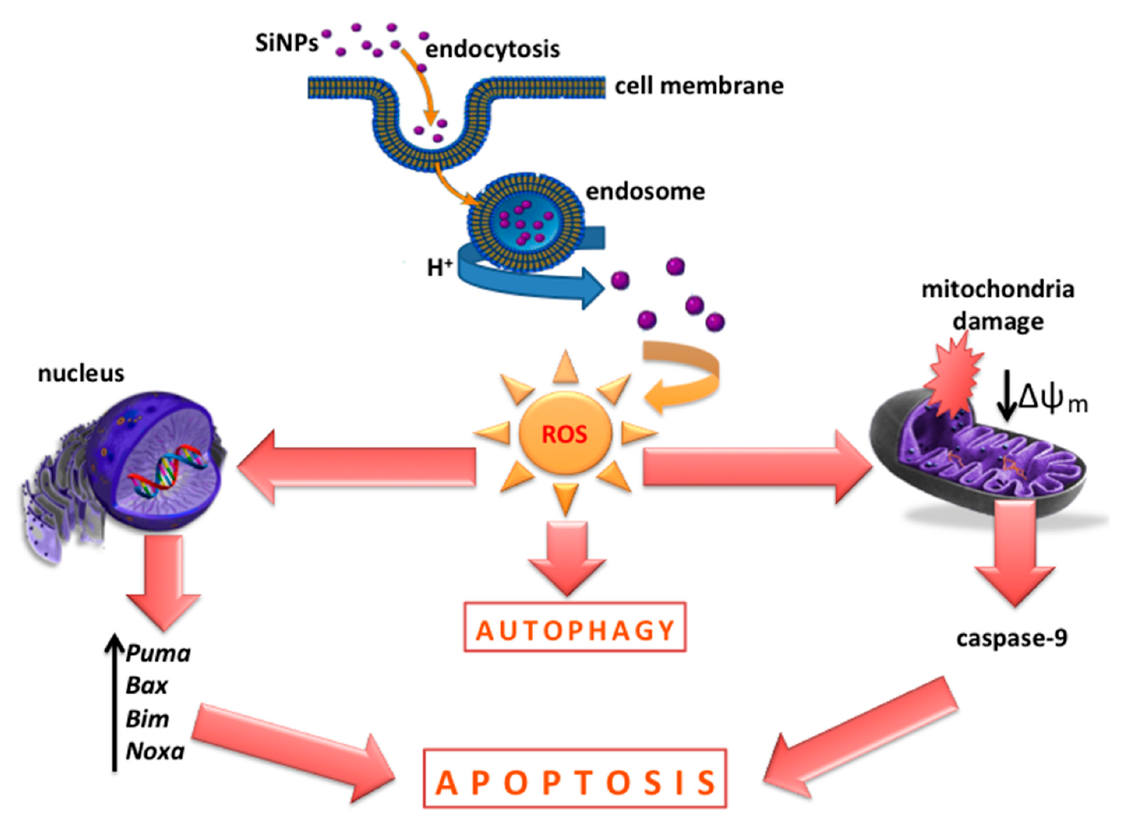
Figure 7. The effect of SiNPs on apoptosis, autophagy, and their suggested mechanism in glioblastoma LBC3 cells.